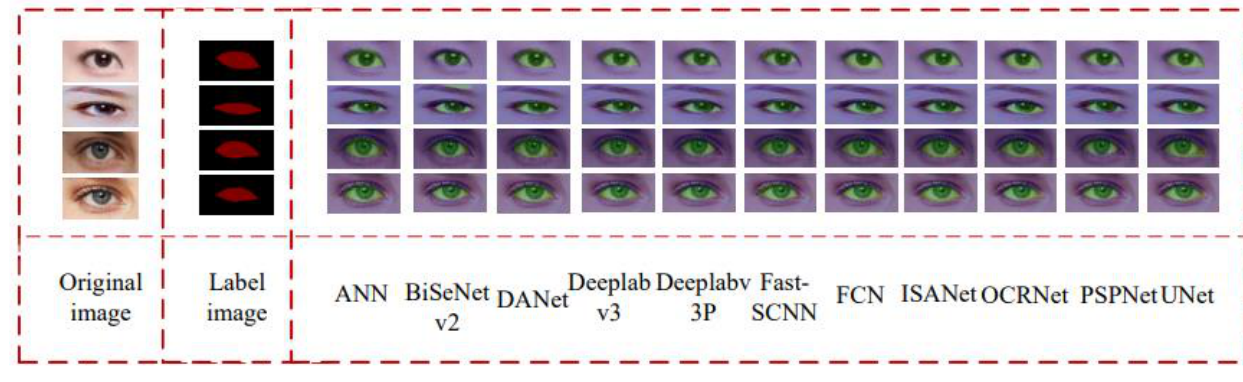
Figure 15. Segmentation result of 11 models on the left eye data. Table 2. Comparison of performance indicators of the 11 models on the left eye data.